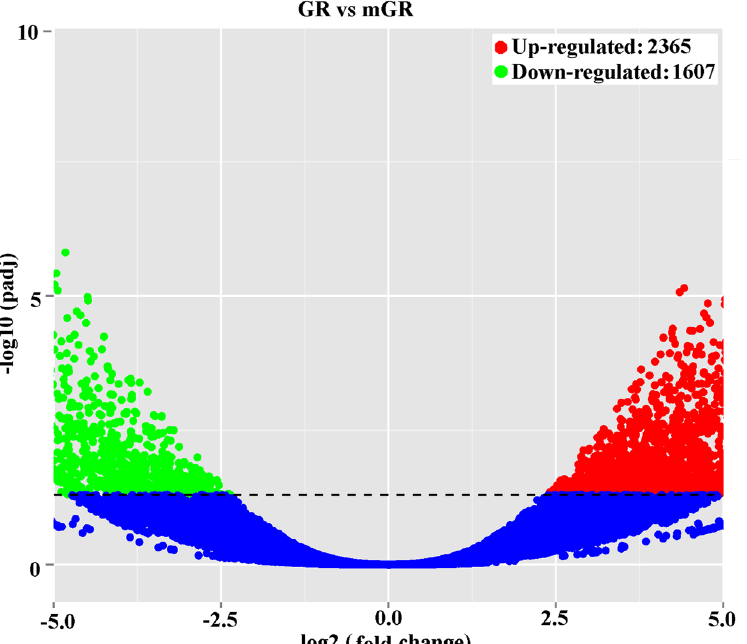
Figure 3. Volcano plot displaying differential expressed genes (DEGs) between GR and mGR samples. The red and green dots represent upregulated and downregulated DEGs, respectively, in the GR samples; the blue dots represent non-DEGs. A total of 3,972 unigenes were identified as differentially expressed (padj <